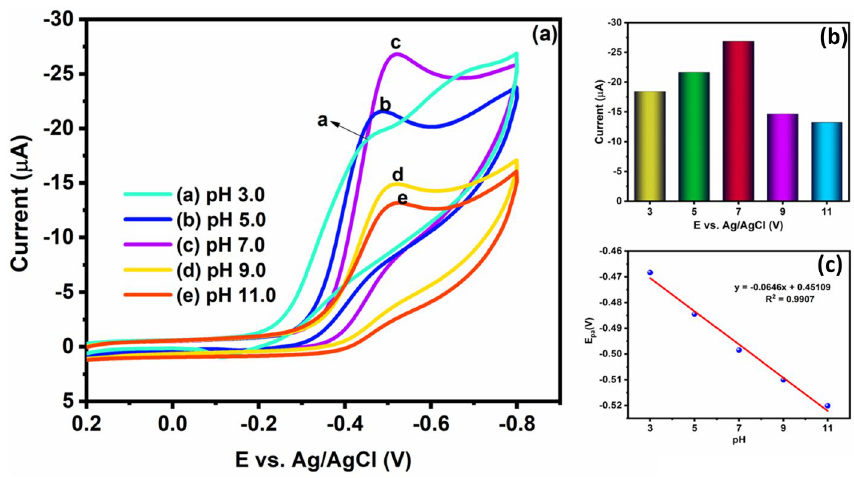
Figure 7. ( a ) CV results of Cu/Ni/TiO 2 /MWCNTs nanocomposites with various pH values. ( b ) peak current for various pH values, and (c) linear coefficient pH vs potential.